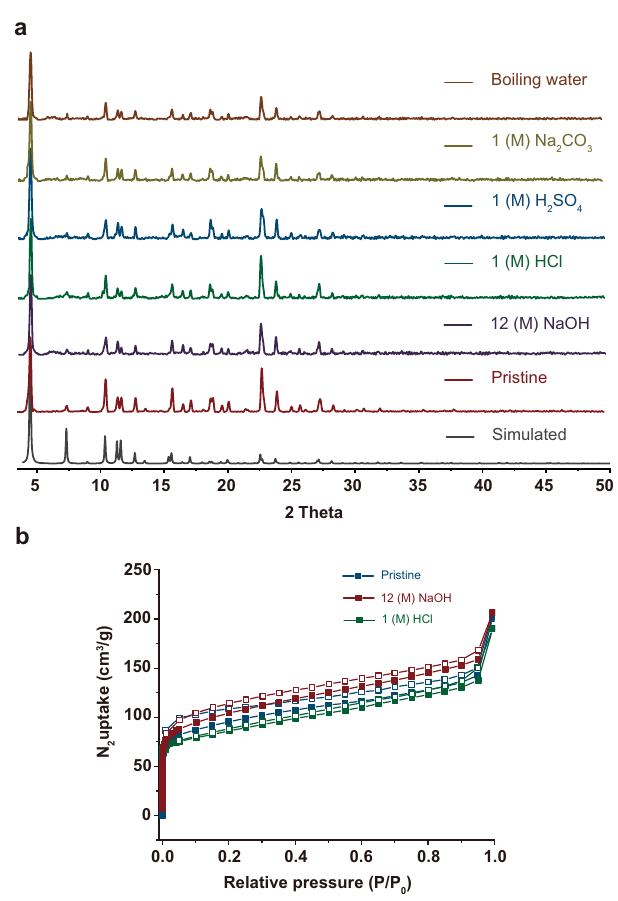
Fig. 5 PXRD patterns and N 2 sorption of 1- S under different harsh conditions. a PXRD patterns measured after 7-day treatment of 1- S in boiling water, 1 M H 2 SO 4 , 1 M HCl, 12 M NaOH, and 1 M Na 2 CO 3 . (N 2 sorption of activated 1- S and 1- S after treatment by NaOH or